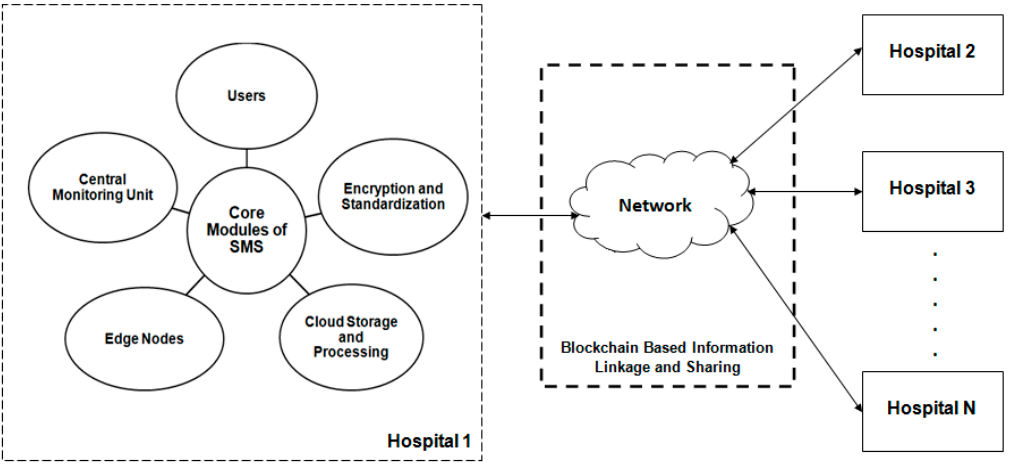
Figure 1. Core components of smart medical system (SMS) in a network.